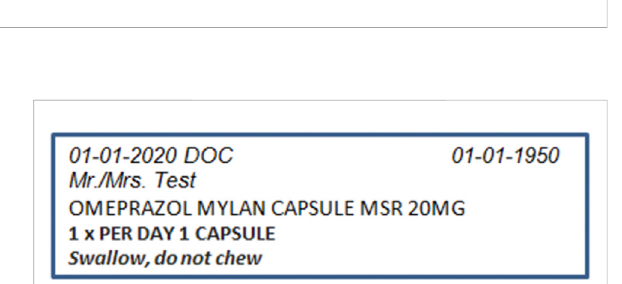
FIGURE 1 Example of MijnGiB overview for three medications.